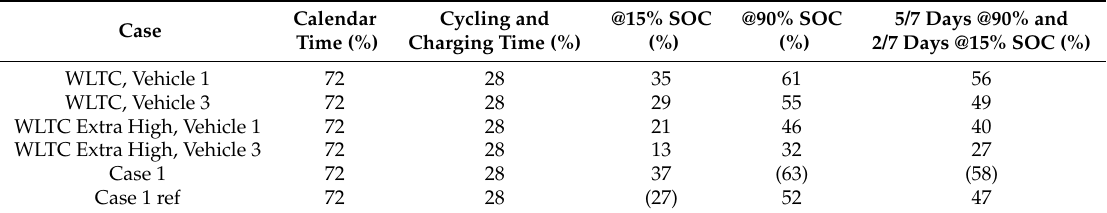
Table 7. Ageing reduction when adding calendar ageing at two different SOC levels to the cycling ageing for six different cases. The values in brackets are only included for comparison since the cases are physically not